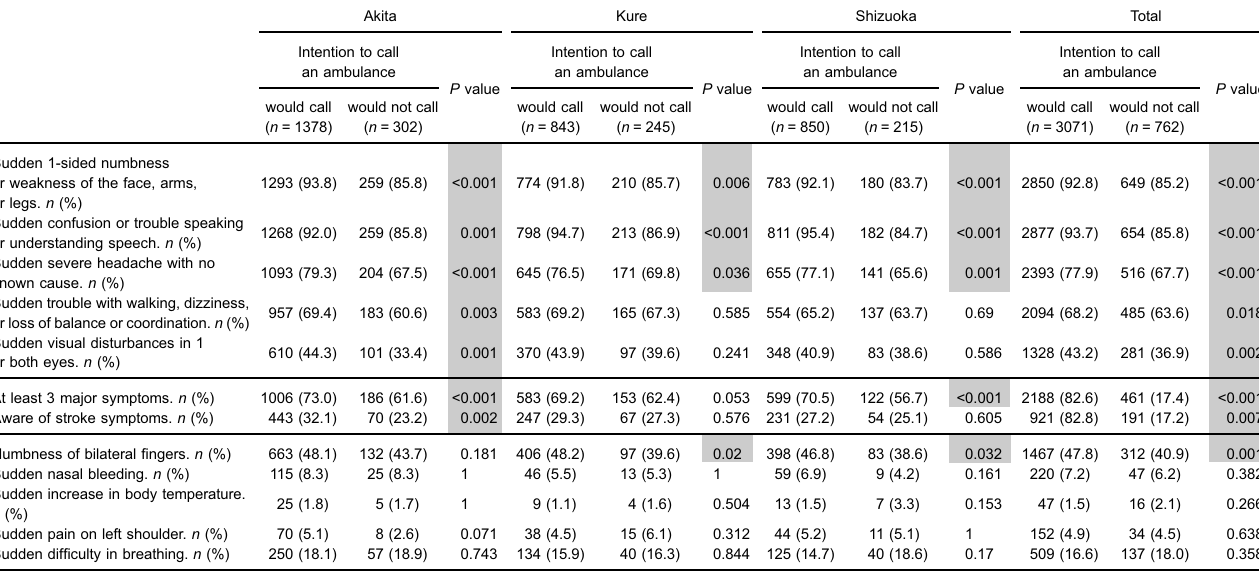
Table 5. Knowledge of stroke symptoms in those who would call an ambulance at stroke in the post-intervention survey Akita Kure